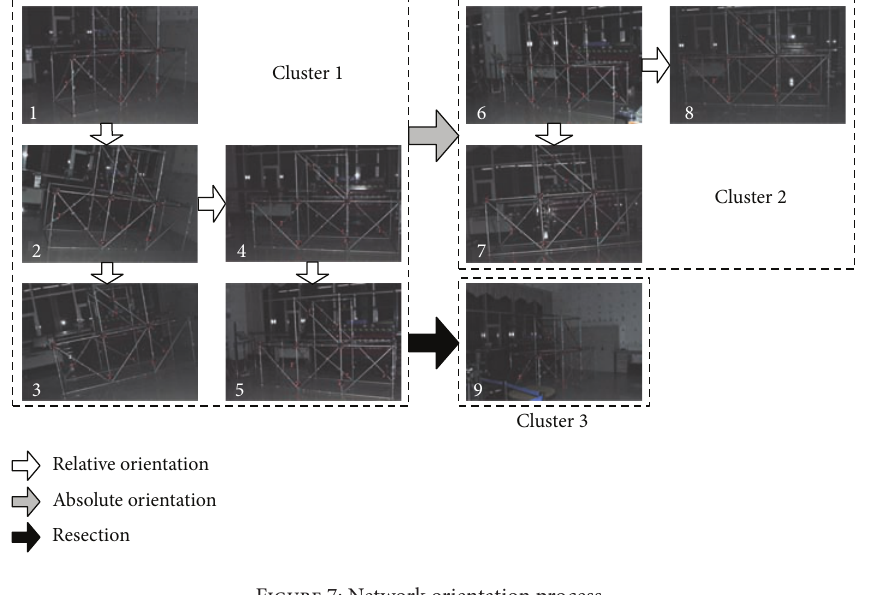
Figure 7: Network orientation process.